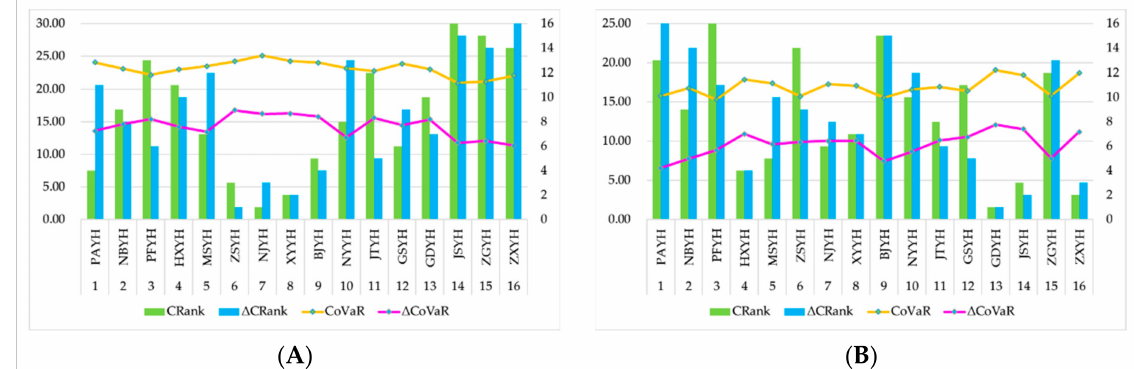
Figure 2. The results (The left axis refers to the values of the CoVaR and ∆ CoVaR of each bank, and the right axis refers to the rankings of the bank in terms of CoVaR and ∆ CoVaR. We use the same formation from Figure 2 to Figure 6) of CoVaR and ∆ CoVaR (In the figure, the CoVaR refers to the Conditional Value at Risk when a bank is in distress; ∆ CoVaR refers to the di ff erence between the CoVaRs when the bank is in distress and in a normal state): ( A ) 2011; ( B )